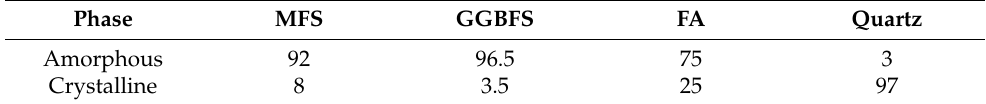
Table 4. Amorphous and crystalline content of the starting materials in wt.%.